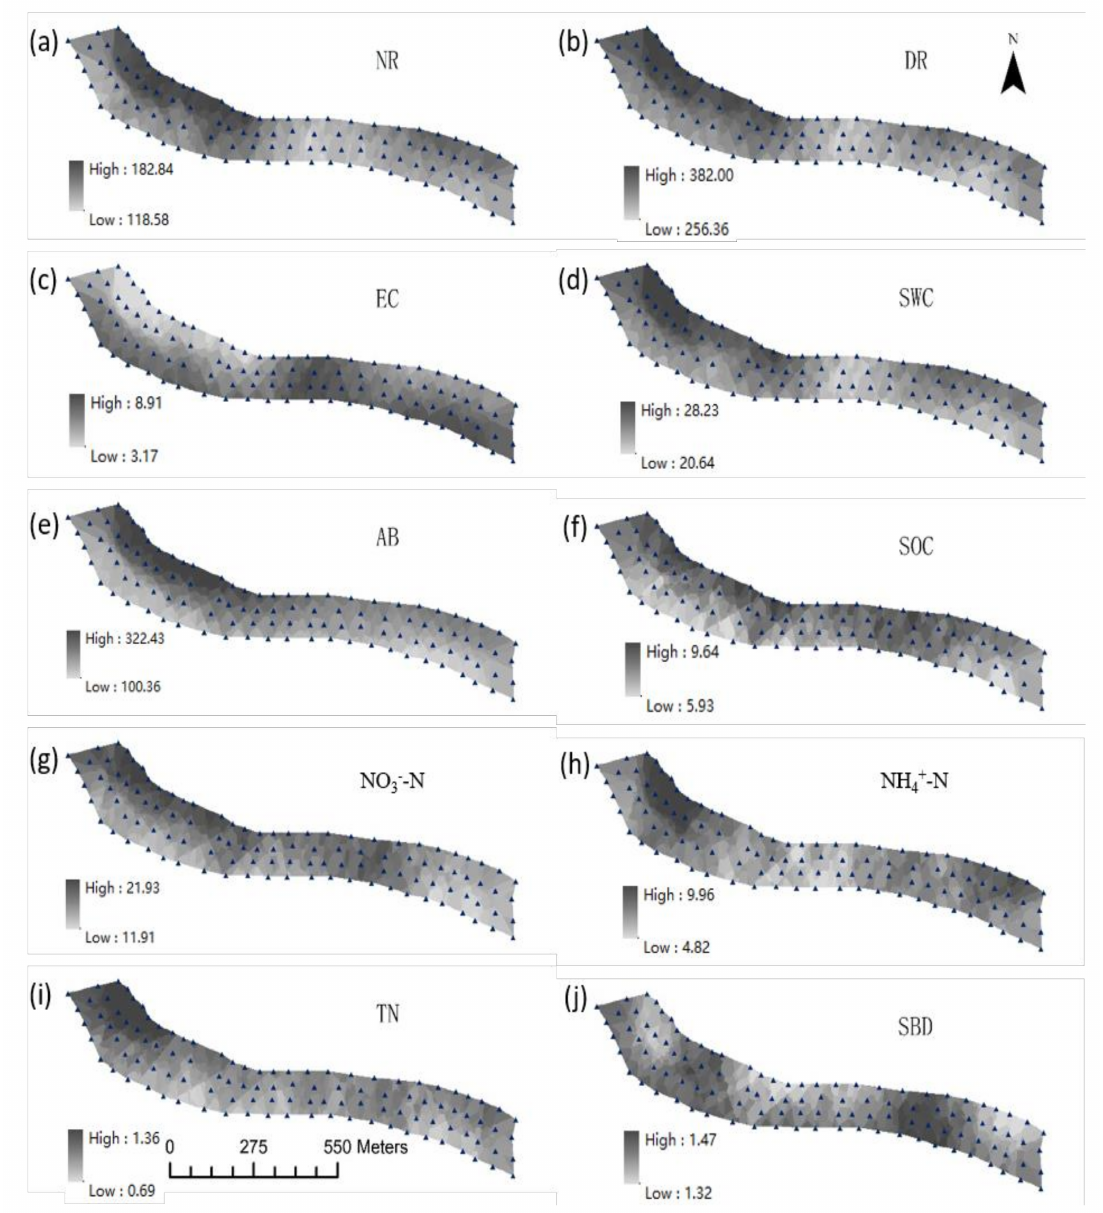
Figure 2. The spatial distribution of ( a ) soil nitrification rates (NR), ( b ) soil denitrification rates (DR), ( c ) soil electrical conductivity (EC), ( d ) soil water content (SWC), ( e ) aboveground biomass (AB), ( f ) soil organic carbon (SOC), ( g ) nitrate-nitrogen (NO 3 − -N), ( h ) ammonium-nitrogen (NH 4 + -N), ( i ) total nitrogen (TN), and ( j ) soil bulk density (SBD) in the studied riparian